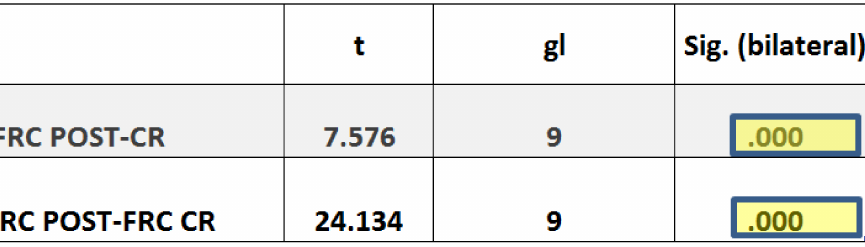
Figure 6. Paired Tukey test di ff erences inter group. p value <